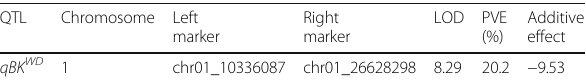
Table 1 Quantitative trait loci (QTLs) detected by composite interval mapping for bakanae disease